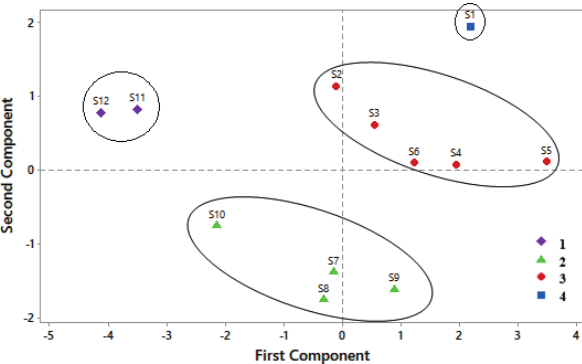
Figure 6. Diagram resulted from principal components analysis 1 (highly related to the position of centromere) and 2 (strongly relat- ed to the length of the complements) of studied berry species.